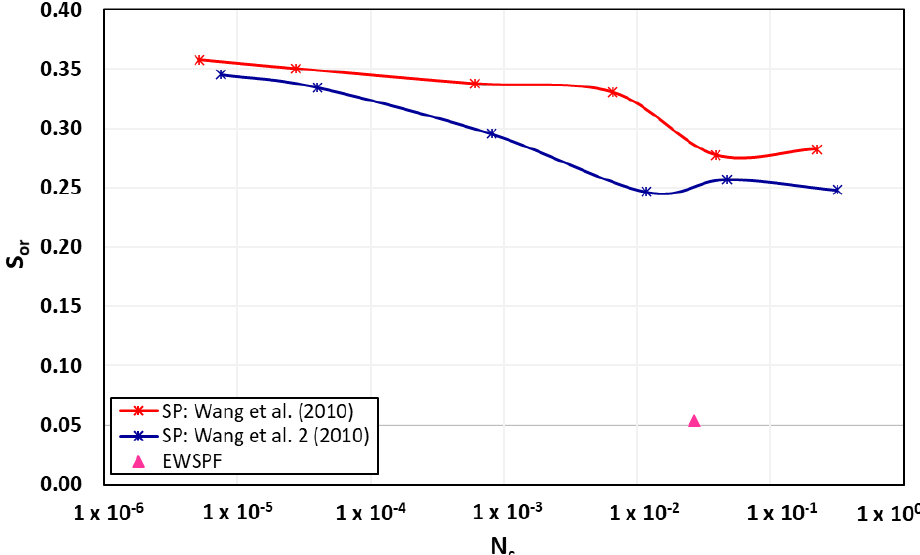
Figure 5. Comparison of capillary desaturation tendency of hybrid EWSPF with conventional SPF.